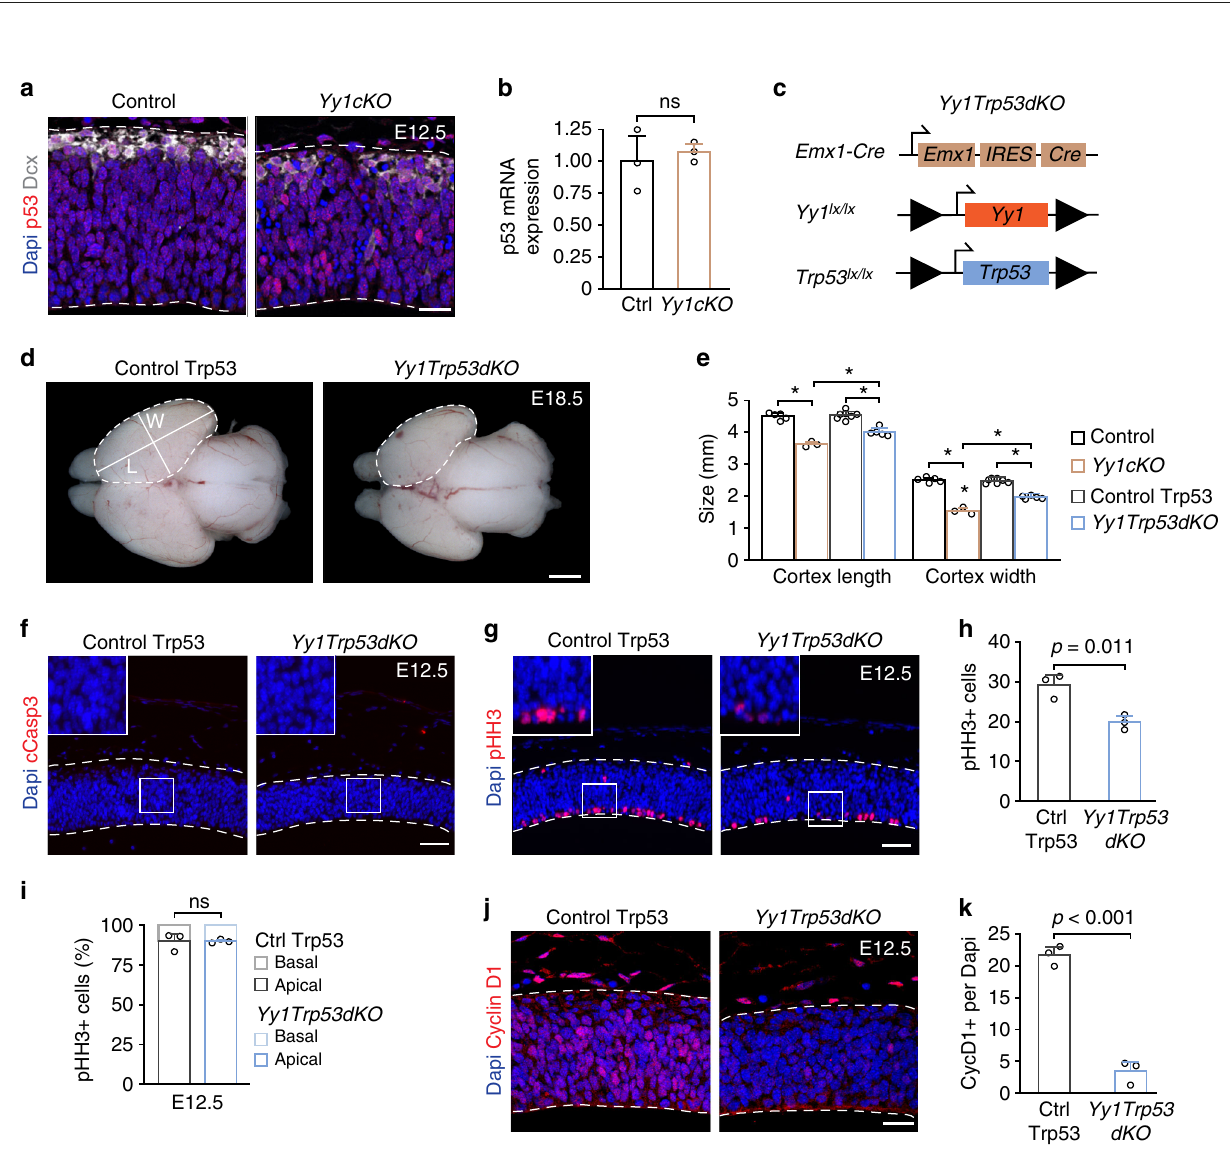
Fig. 2 Ablation of Yy1 after E12.5 does not in fl uence cortical development. a Genotype of mice and experimental strategy used to induce ablation of Yy1 at different developmental stages. b Later stage tamoxifen-induced ablation of Yy1 ameliorates the decrease in cortex size compared with Yy1cKO cortices (Fig. 1b). c Measurement of cortical length (L) and width (W) as indicated in b . For representative picture of E18.5 Yy1cKO cortex, see Fig. 1b. * p <0.05. d Experimental strategy to ablate Yy1 at E12.5 in Yy1iKO embryos (for Fig. 2e – k). e – h Immunostaining and quanti fi cation for pHH3 + cells at E14.5 ( e , g ) and E15.5 ( f , g ) in E12.5-ablated Yy1iKO embryos. h depicts the ratio of apical vs. basal pHH3 + cells. The number of pHH3 + cells is normalized to 600 μ m ventricular zone length. i – k Ablation of Yy1 at E12.5 elicits cleavage of Caspase 3 (cCasp3) at E14.5 ( i , k ) but not at E15.5 ( j , k ). Note that red signals visible at E15.5 are blood cells. l Experimental strategy to ablate Yy1 at E13.5 in Yy1iKO embryos (for Fig. 2m – q). m – o The total number and ratio of apical vs. basal pHH3 + cells remains unchanged upon late ablation of Yy1 at E13.5. The number of pHH3 + cells is normalized to 600 μ m ventricular zone length. p , q Ablation of Yy1 at E13.5 only induces cell death in a minority of cells (indicated by arrows, remaining red signals are blood cells). Nuclei are counterstained with DAPI. Scale bars represent 1mm ( b ), 50 µ m ( e , f , i , j , m , p ). Comparisons were performed using ANOVA (Tukey ’ s multiple comparisons test) ( c ) and two-tailed unpaired Student ’ s t test ( g , h , k , n , o , q ). Data are the mean ±standard deviation. ns = not signi fi cant